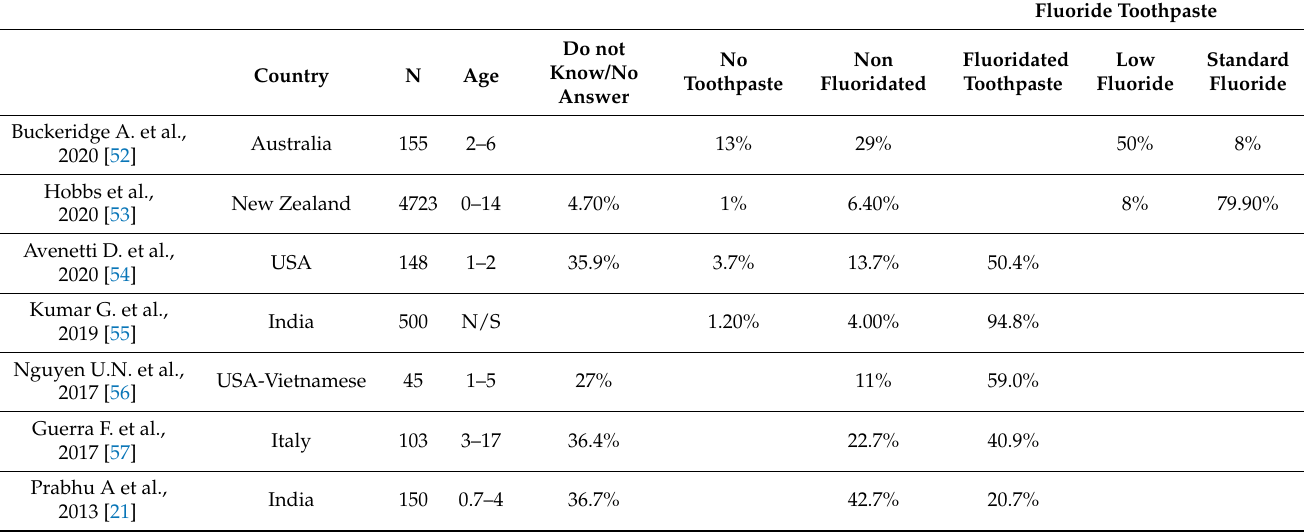
Table 1. Frequency of use of fluoridated toothpaste among different populations. Author,